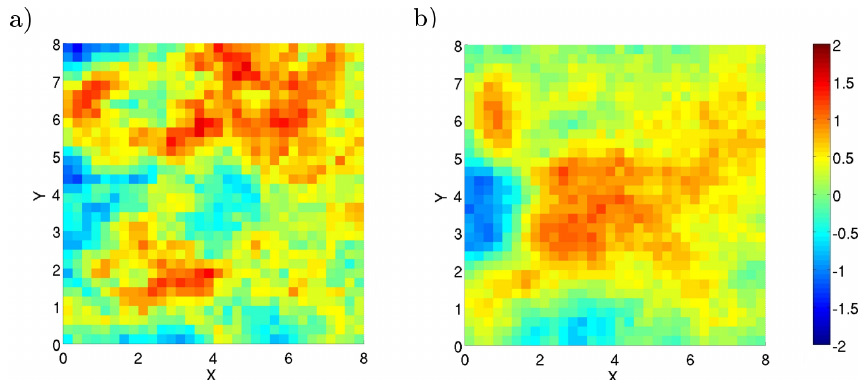
Fig. 9. Scenario 4: log-transformed hydraulic conductivity field retrieved by (a) the EnKF and (b) ES using concentration data transformed with a modified normal score transform. The color bar indicates log-transformed hydraulic conductivity in ln (L/T ) .